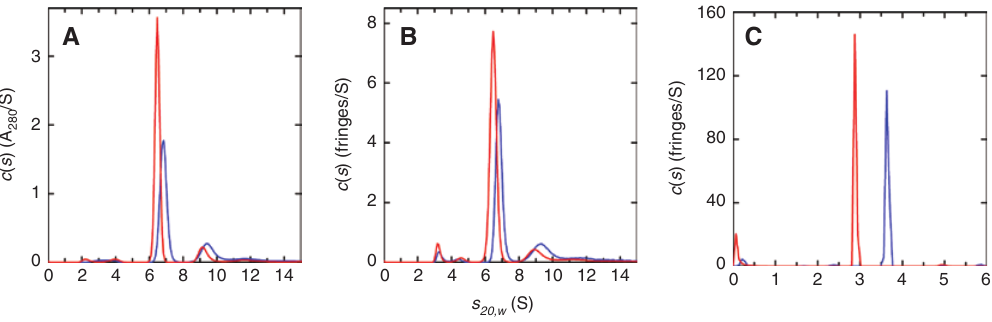
Figure 5: Sedimentation velocity of MSP1D1 nanodiscs reconstituted with POPC (red curves) or POPG (blue curves). (A) Absorbance c( s ) distributions for NTS1 reconstituted into nanodiscs. The integral of the distribution reports on the scaffold and membrane protein con- centrations. (B) The corresponding interference c( s ) distributions for the same sample of NTS1 reconstituted into nanodiscs. Absorbance and interference data were collected in the same SV experiment. The integral of the interference distribution reports on the contributions from scaffold and membrane proteins, as well as the lipids, allowing for an estimate of the lipid stoichiometry in the sedimentation region of interest. The major species observed at 6.4–6.9 S represent the MSP1D1 lipid nanodisc containing a single copy of NTS1. (C) Interfer-